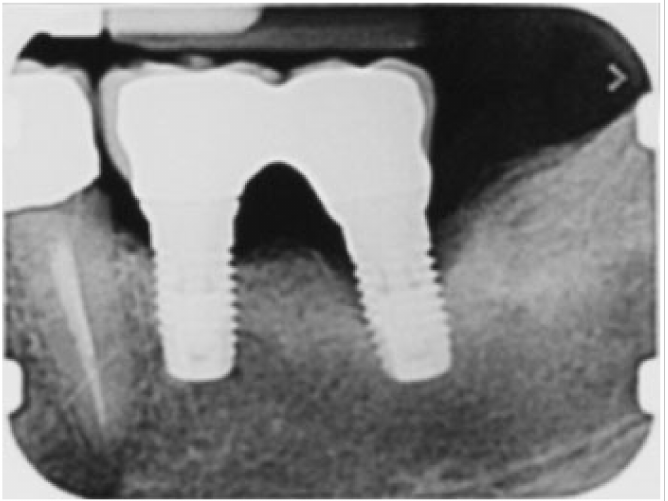
Figure 2. Rx periapical before peri-implant therapy: infra-bony defect around the distal implant. A crackling sensation with no tenderness was detectable on palpation of the subcuta- neous tissue in the swelling area. Visual acuity, light reflex, and extraocular movements were intact. Intraoral examination showed no swelling or crepitus in the mandibular region